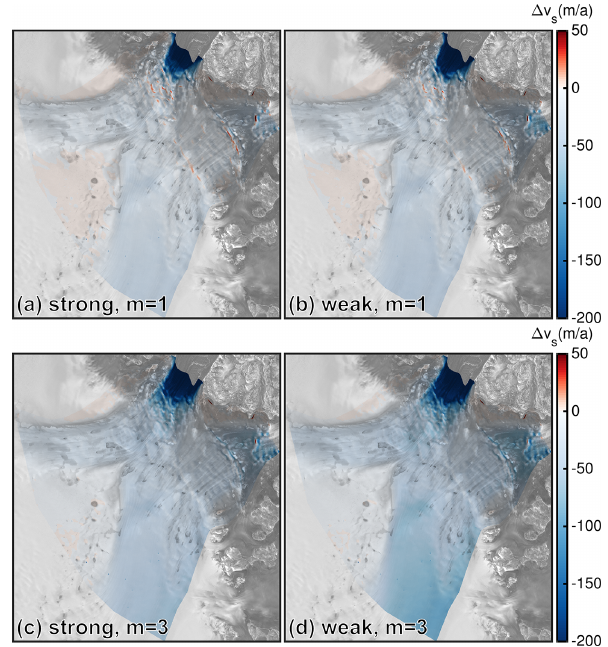
Figure 7. Difference of surface velocity (cid:49)v FS − BP-like s = v FS s − v BP-like s in the outlet domain for a resolution of 150m and the P1P1GLS discretization. (a, b) Differences for m = 1 and the strong and weak friction implementations, respectively. (c, d) Differences for m = 3 and the strong and weak friction implementations, respec- tively. Please note the different colour bar compared to Fig. 4. Back- ground image is a RADARSAT Mosaic (Joughin, 2015; Joughin et al., 2016).